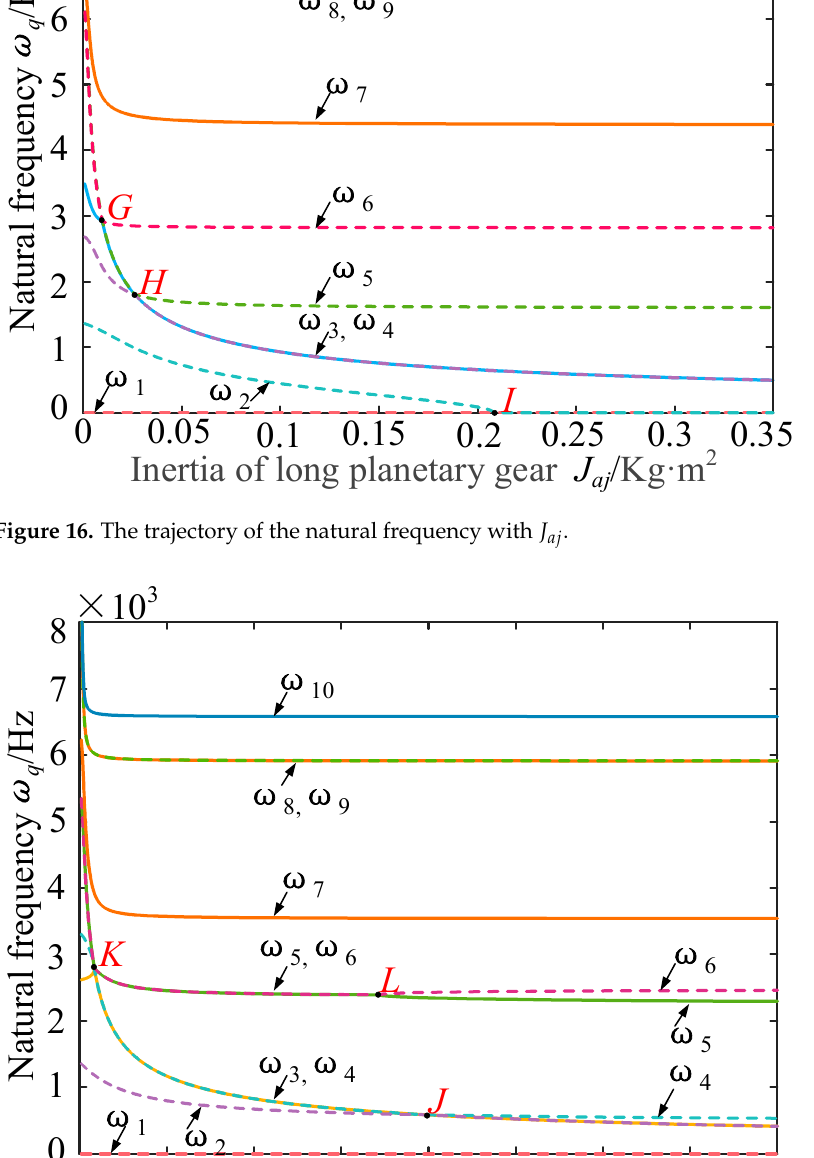
Figure 17. The trajectory of the natural frequency with J bj . Simulation condition: the rated speed is 2300 r/min, the mean torque is 2000 N.m and the fluctuation frequency is six times the rotation frequency of the crankshaft. As seen in Figure 18a,b, the planet carrier and the gear ring are completely overlapped in frequency; namely, their vibration is caused by the same excitation and their vibration frequency coincides completely. It can be seen that the low-frequency components of the vibration are mainly composed of engine rotation frequency f e , modulation frequency f c , f s – f c , the high-frequency components of the vibration are mainly composed of the